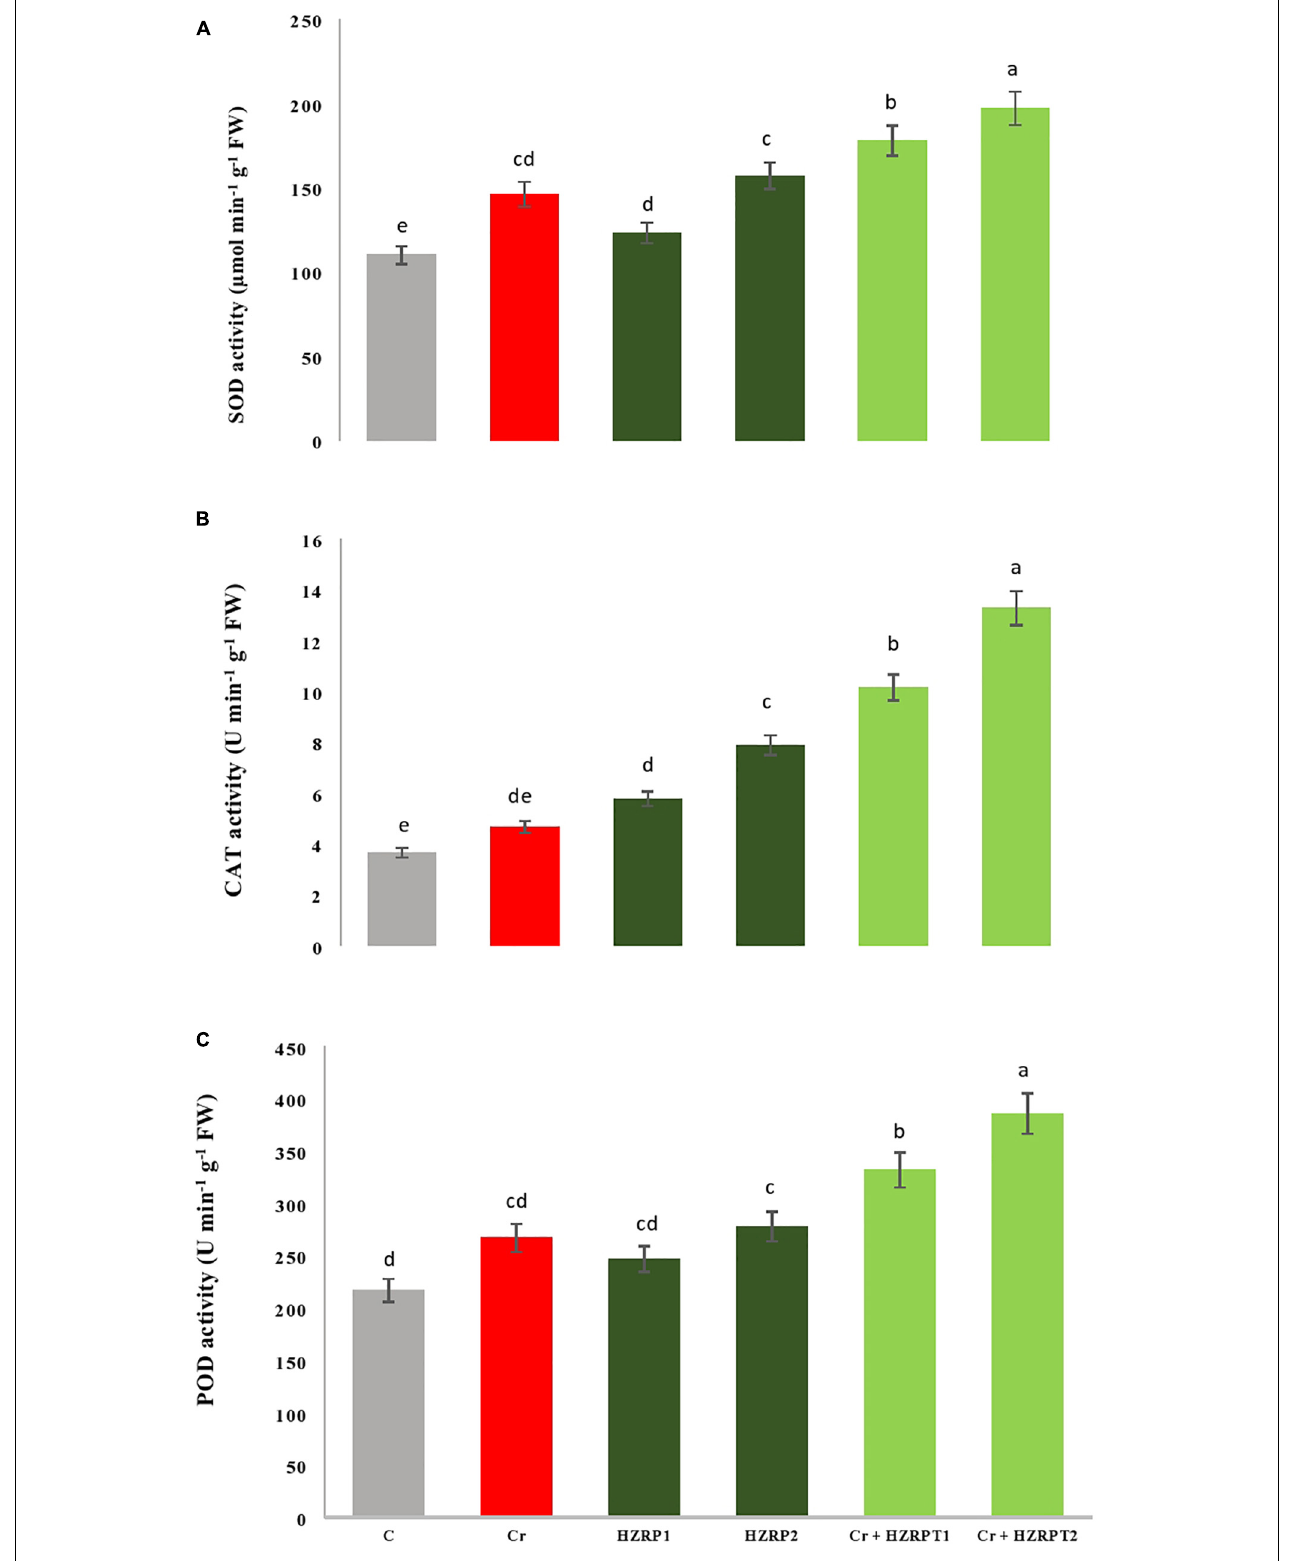
FIGURE 3 | Effect of HZRP on SOD (A) , CAT (B) and POD (C) activity in V. radiata seedlings grown in Cr toxificaled soil. Different letters indicate significant difference among the treatments ( p < 0.05). Cr. 50 mg kg 1 , HZRP1, 1 p.p.m; HZRP2. 2 p.p.m.